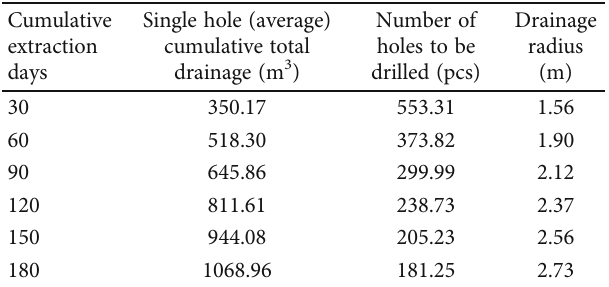
Table 3: Comparison of the calculation results of the drilling radius.